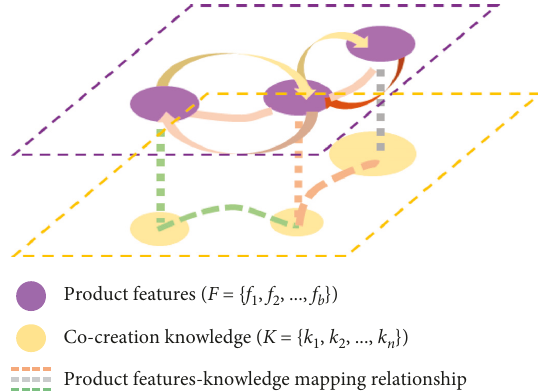
Figure 11: Product network-knowledge network mapping